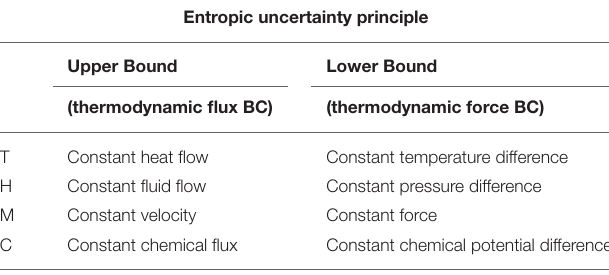
TABLE 1 | Multi-physics boundary conditions to calculate upper and lower limits of entropy production from each length